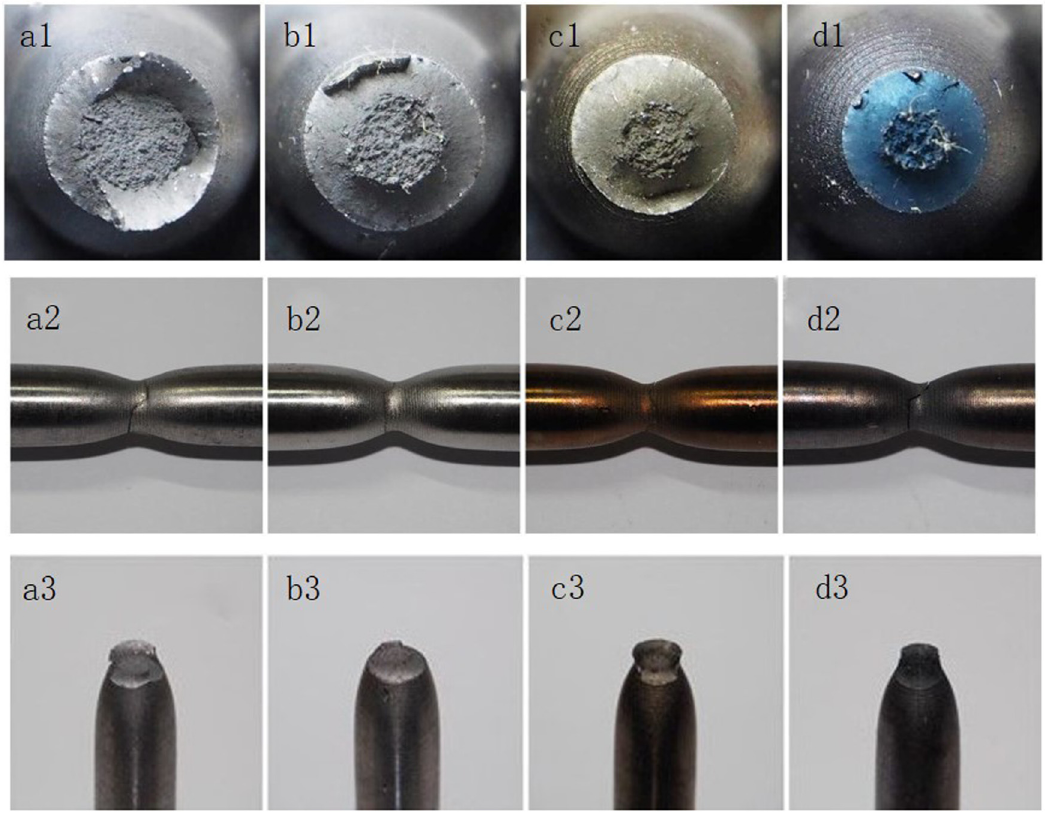
Figure 5: Macroscopic morphology of fracture of 30CrMo after high - temperature tensile test: ( a ) 25°C, ( b ) 150°C, ( c ) 250°C, and ( d )